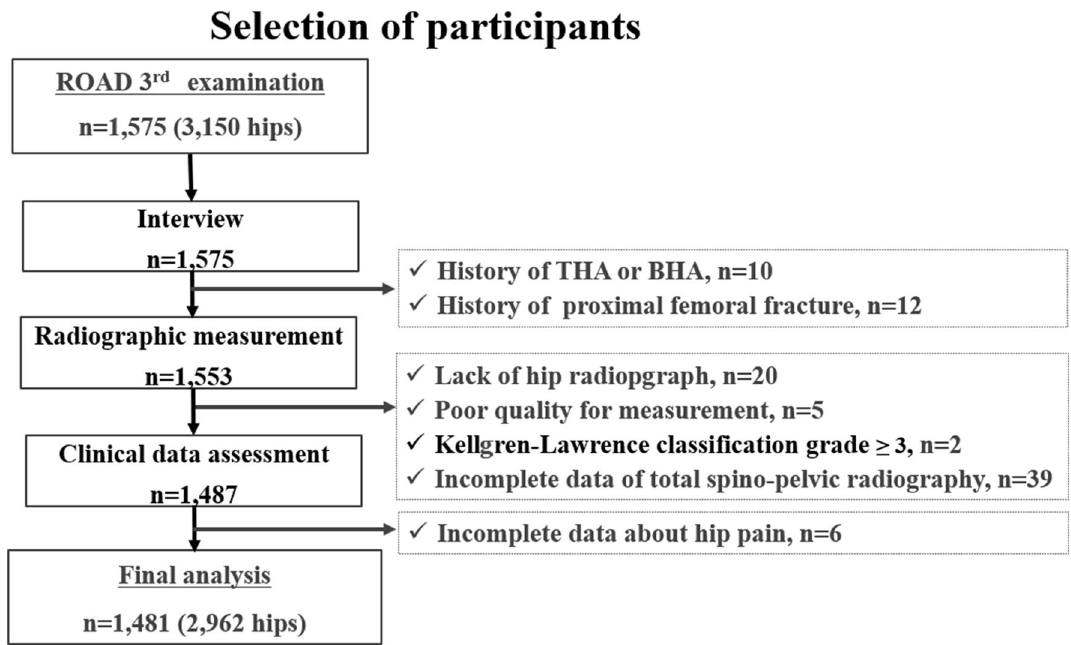
Figure 1. Flow diagram depicting the study enrollment strategy. Participants in the study are recruited from the residents who participated in the 2012 and 2013 examinations for clinical evaluation, as a part of the Research on Osteoarthritis/Osteoporosis Against Disability (ROAD) study. THA, total hip arthroplasty; BHA, bipolar hip arthroplasty.